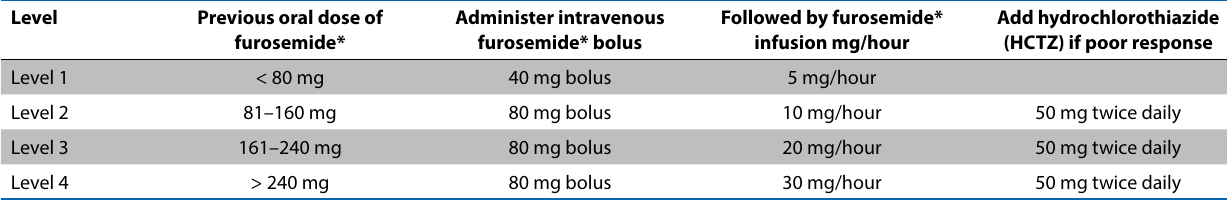
Table I. Recommended intravenous loop diuretic dosing in acute heart failure with systolic blood pressure > 100 mmHg Level Previous oral dose of Administer intravenous furosemide* furosemide*